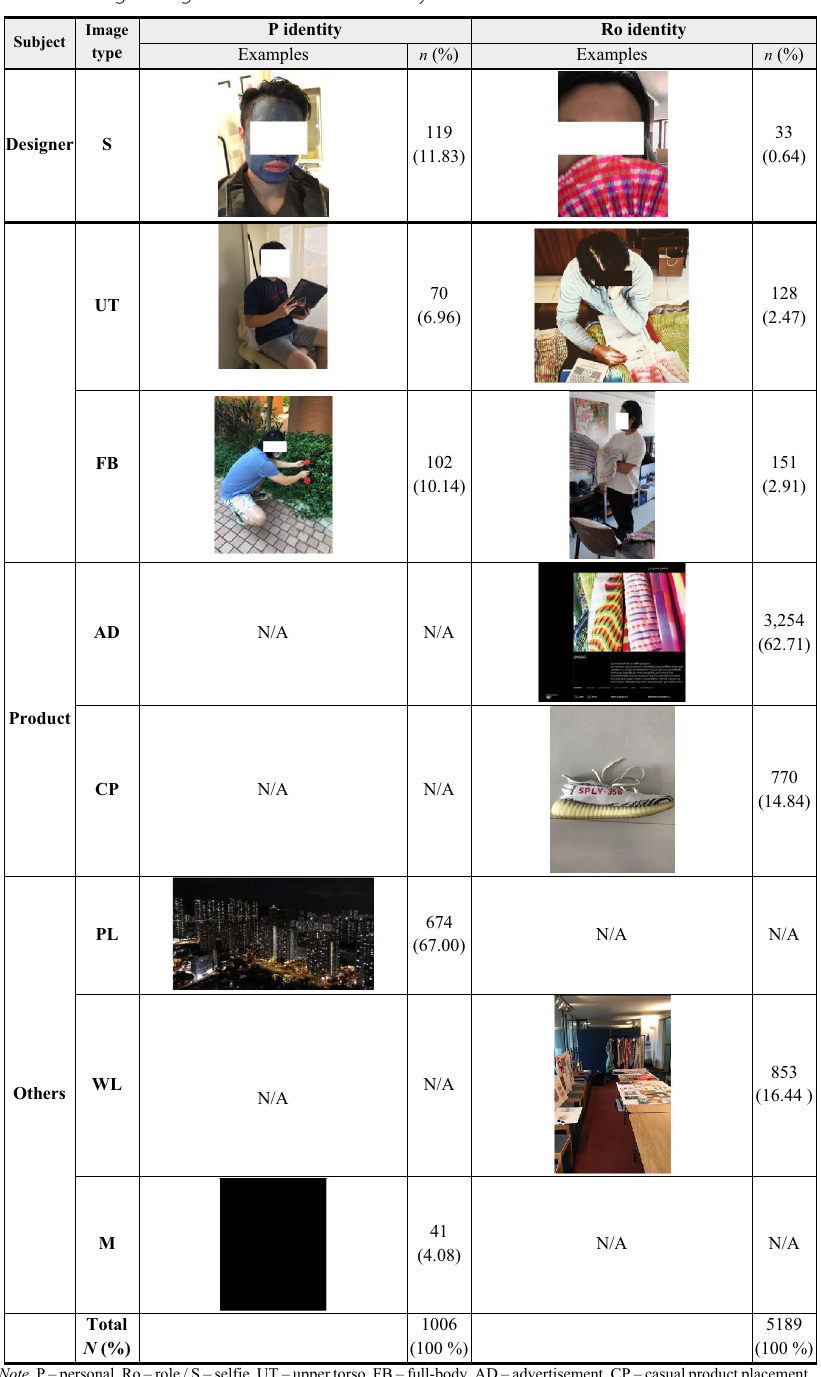
Table 5 Image categorisation of P & Ro